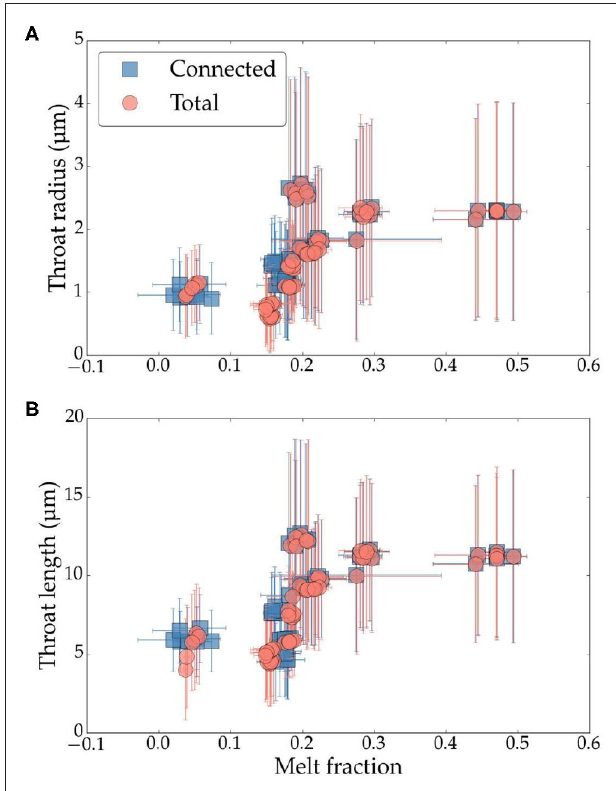
FIGURE 7 | Plots of (A) median throat radius and (B) throat radius as a function of melt volume fraction in all subvolumes. The horizontal axis represents values of connected melt fraction for the filled squares and total melt fraction for filled circles. Error bars for melt volume fraction are given by the difference between automatically thresholded and manually thresholded melt fractions. Error bars for throat radius and lengths are given by the standard deviation (1 σ ) of the measured